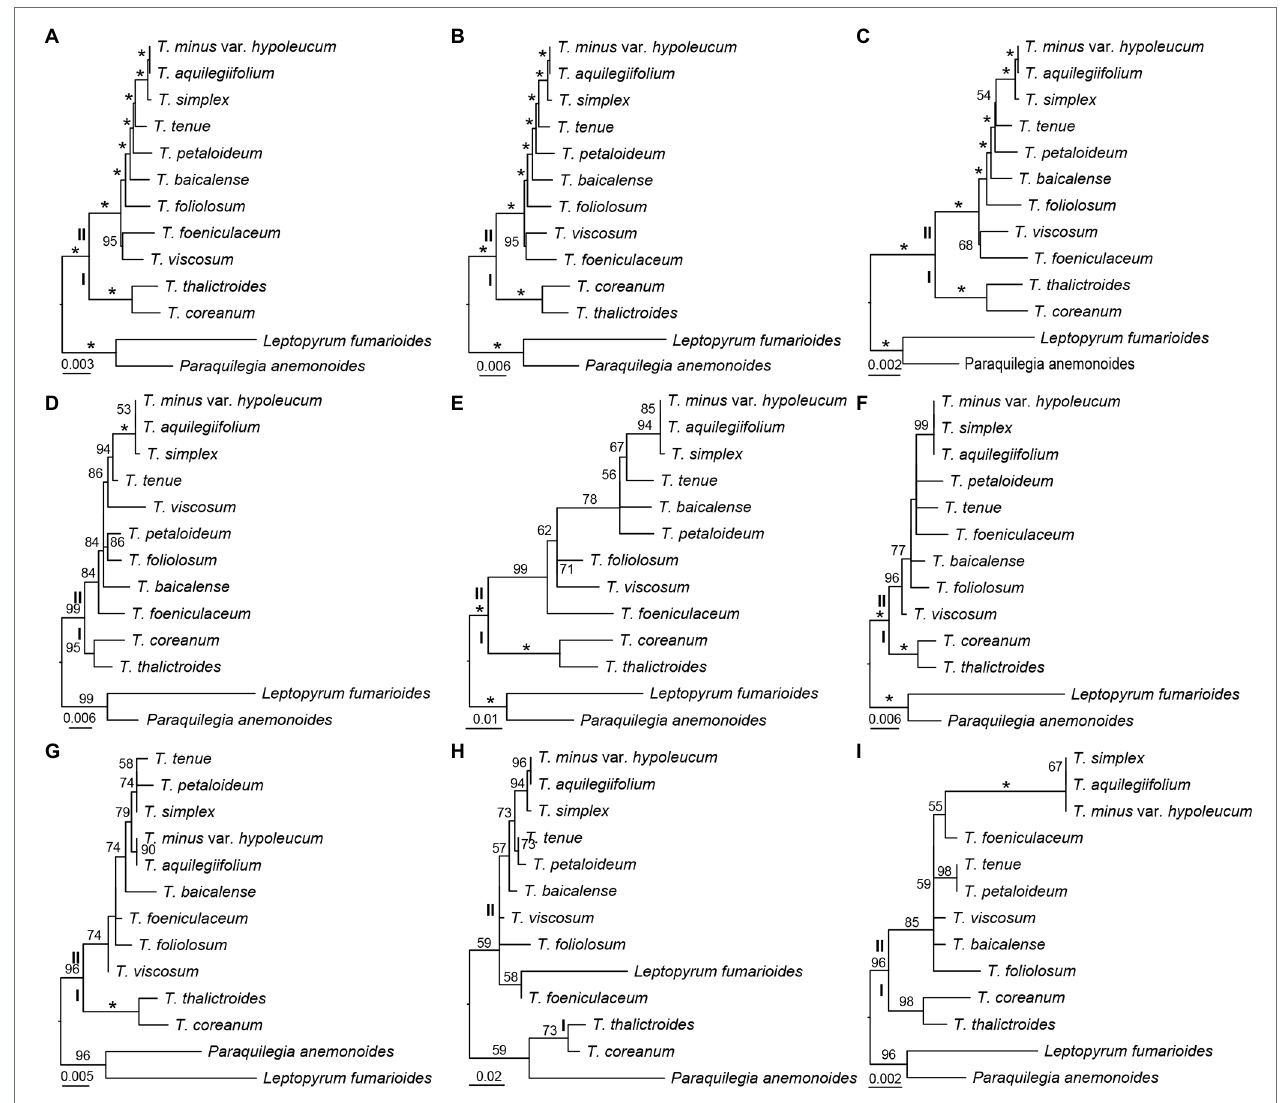
FIGURE 4 | Phylogenetic relationships of Thalictrum inferred from maximum likelihood (ML) analysis. (A) All sequence, (B) concatenation of 115 IGS regions, (C) concatenation of 114 gene sequences, (D) rpl16 (with intron, Soza et al., 2012), (E) ndhC-trnV UAC (Soza et al., 2013), (F) ndhA intron (Wang et al.,